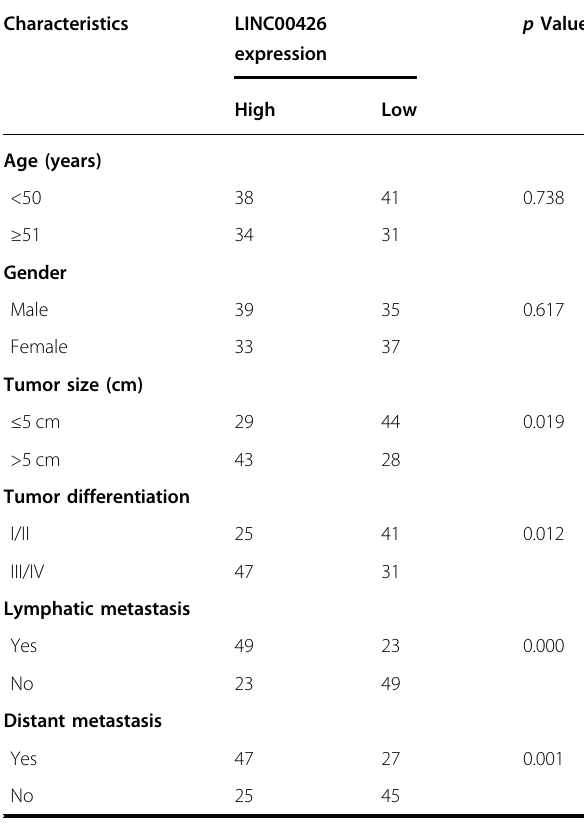
Table 1 Correlations between Linc00426 expression and clinicopathological characteristics in 144 patients with